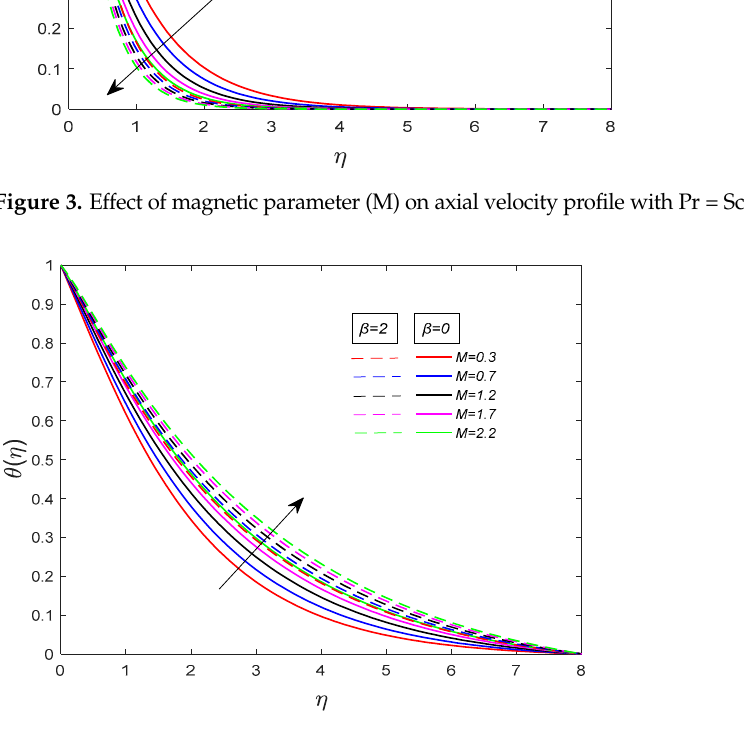
Figure 4. Effect of magnetic parameter (M) on temperature profile with Pr = Sc = 0.7, Ec = Kr = Sr = 0.1.